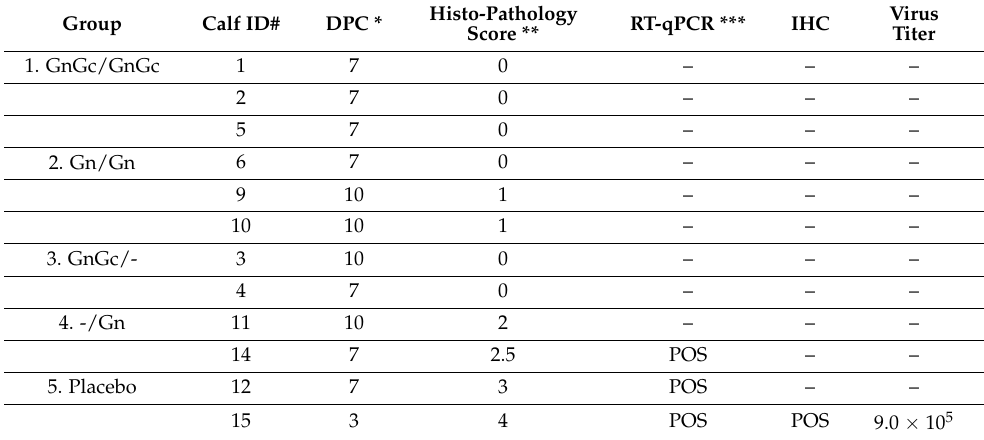
Table 1. Histopathology scores, presence of RVFV antigen, RVFV RNA and infectious virus in the liver. Group Calf ID# DPC